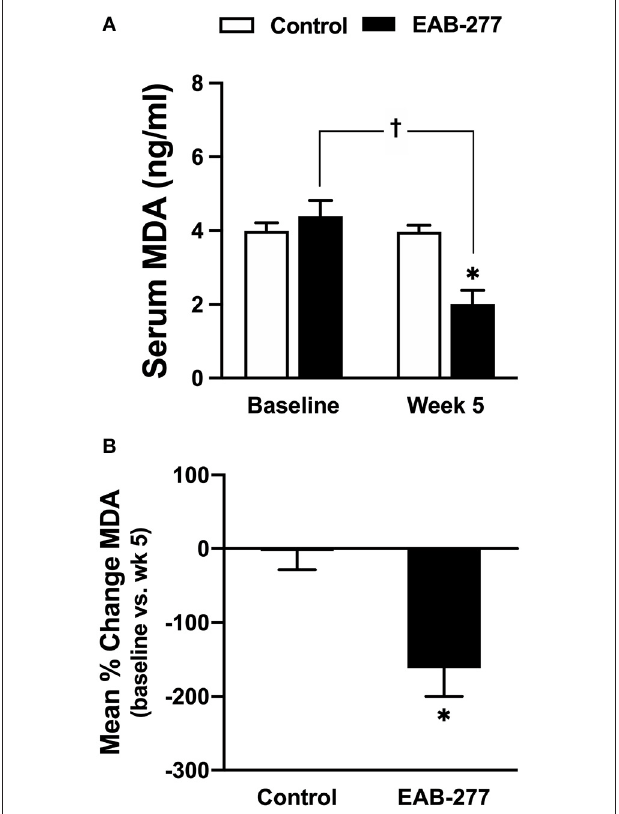
FIGURE 3 | Effect of a standard treatment plus EAB-277 ® on serum MDA levels in tracheal collapse dogs. Serum MDA level before and after treatment was not different in the control group, whereas serum MDA level was decreased at week 5 in the treatment group compared to the control group and compared to the treatment group at baseline (A) . Moreover, the mean percent change of serum MDA at week 5 in the treatment group was greater than the mean percent change in the control group (B) . * P ≤ 0.05 compared to the control group. † P ≤ 0.05 compared to baseline in the same